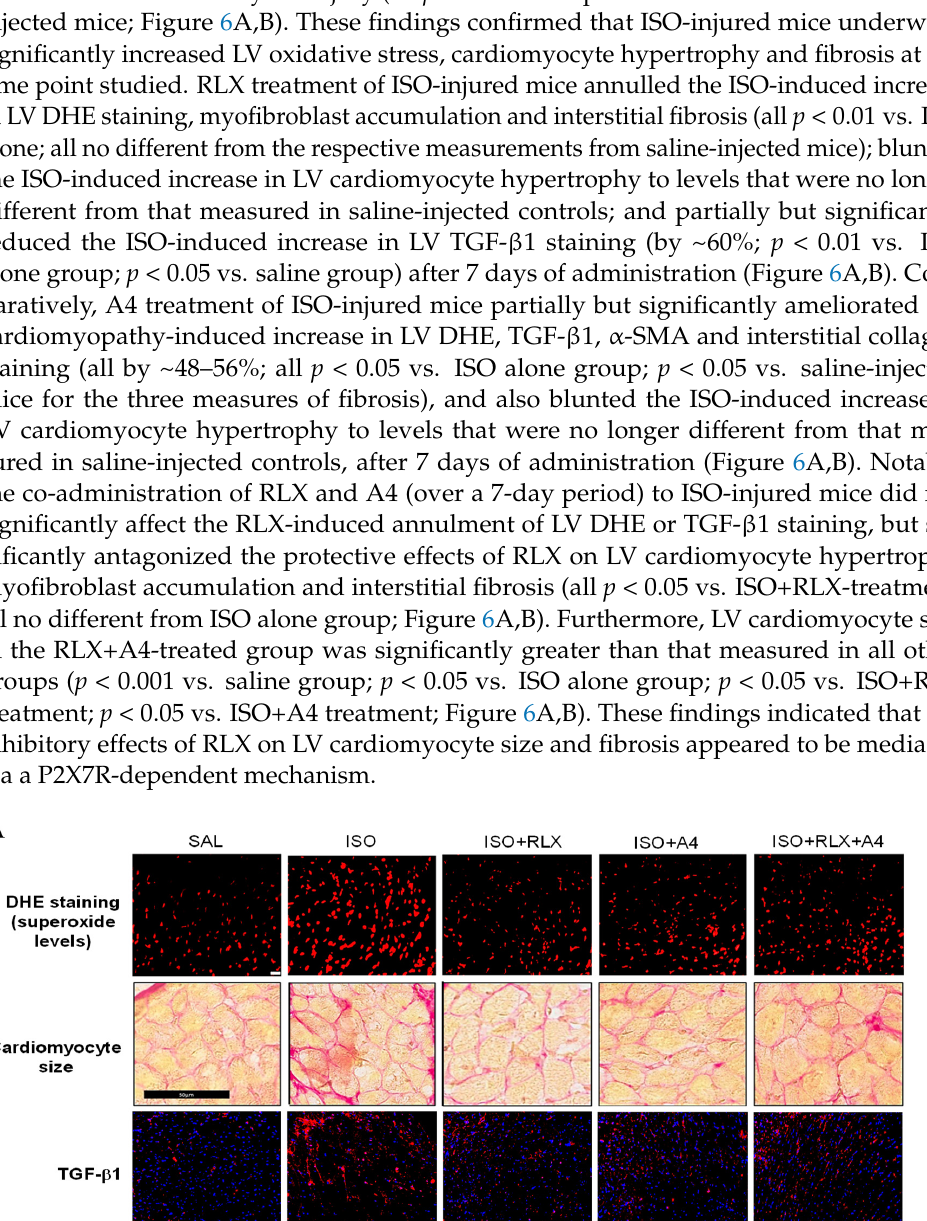
Figure 6. The effects of ISO as well as RLX and/or A4 treatment on measures of LV oxidative stress, cardiomyocyte hypertrophy and fibrosis. ( A ) Representative immunofluorescent-stained images of LV DHE-stained superoxide levels (red staining), cardiomyocyte size and interstitial TGF- β 1 (red staining, counterstained with DAPI (blue) staining of cell nuclei) α -SMA (red staining, counter- stained with DAPI (blue) staining of cell nuclei) and interstitial collagen deposition (red-staining) from saline (SAL)- or ISO-injected mice at day 14, and from ISO-injured mice that were treated with RLX (R), A4 or R+A4 from days 7–14 post-injury. Scale bar = 50 µm or 2 mm for the picrosirius red- stained LV sections. ( B ) Also shown is the mean ± SEM % fractional area of each of the end points measured, from n = 6 non-overlapping fields per section or >100 cardiomyocytes per section and n = 6–7 mice per group. The individual data sets for each group are represented by the white circles within each set of bar graphs. * p < 0.05, ** p < 0.01, *** p < 0.001 compared to the SAL group; # p < 0.05, ## p < 0.01, ### p < 0.001 compared to the ISO group; ¶ p < 0.05 compared to the ISO+RLX-treated group; § p < 0.05 compared to the ISO+A4-treated group.